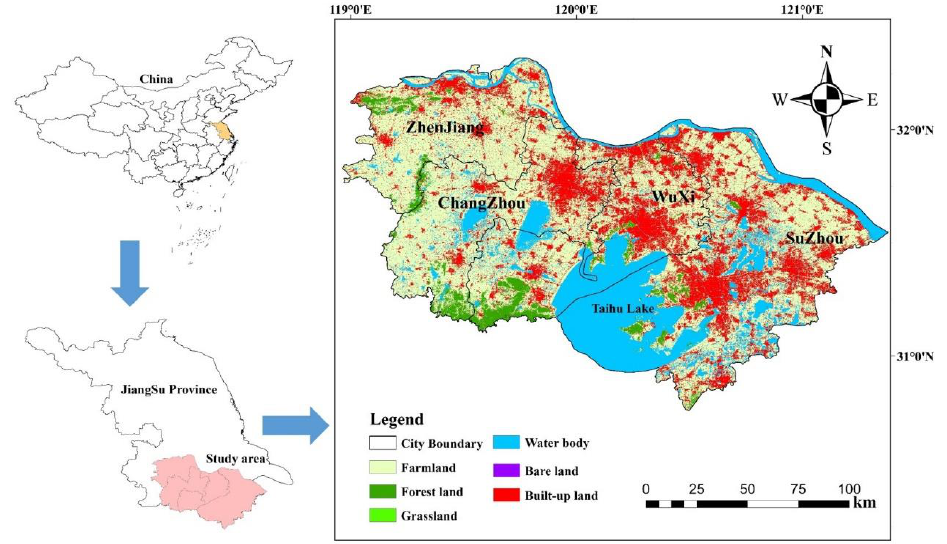
Figure 1. Geographical location and land use of SCBJ